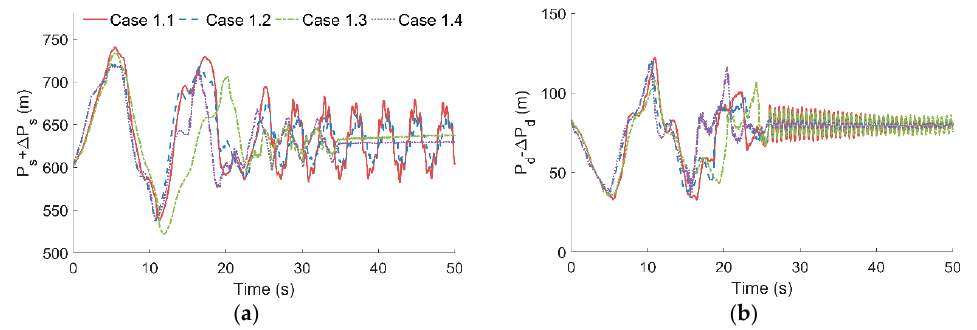
Figure 14. Comparison of dynamic pressure envelopes between subcases in Case 1 at ( a ) the spiral case and ( b ) the draft